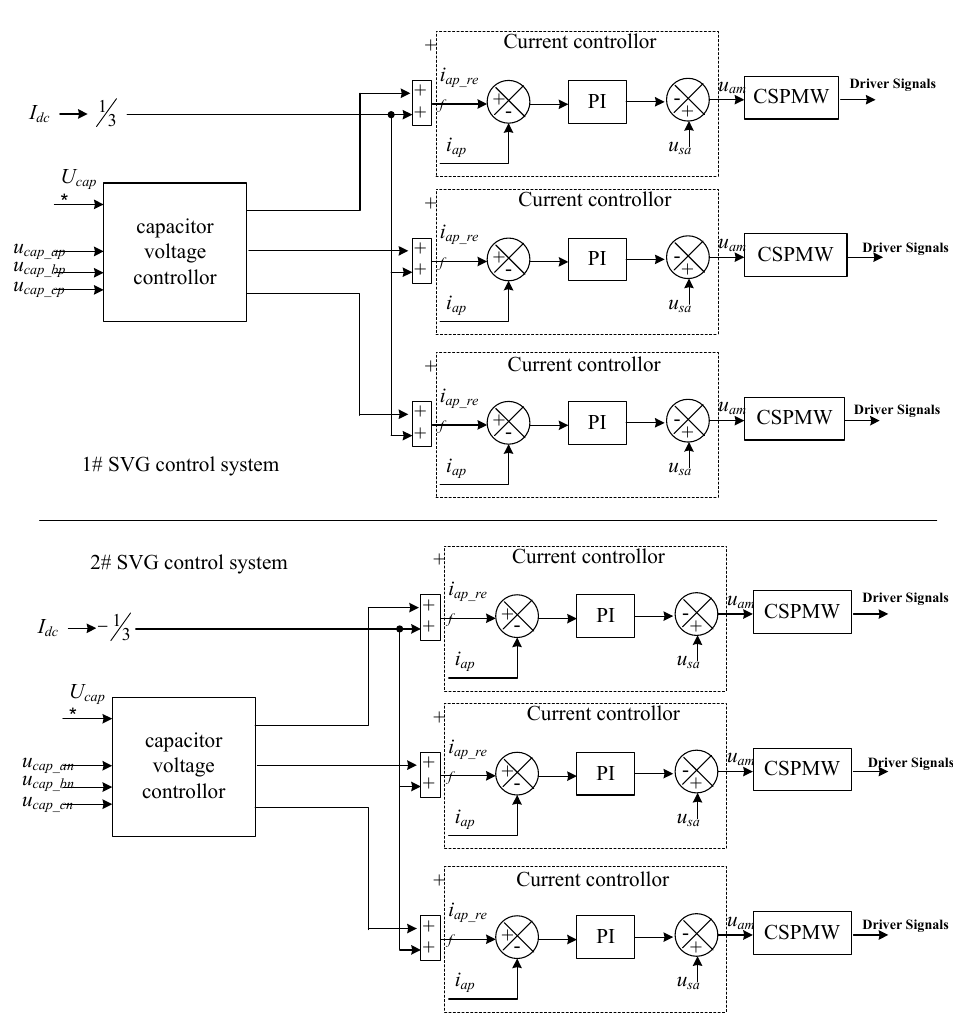
Figure A2. The circuit image of MMC-DDI simulation model built in Matlab/Simulink.